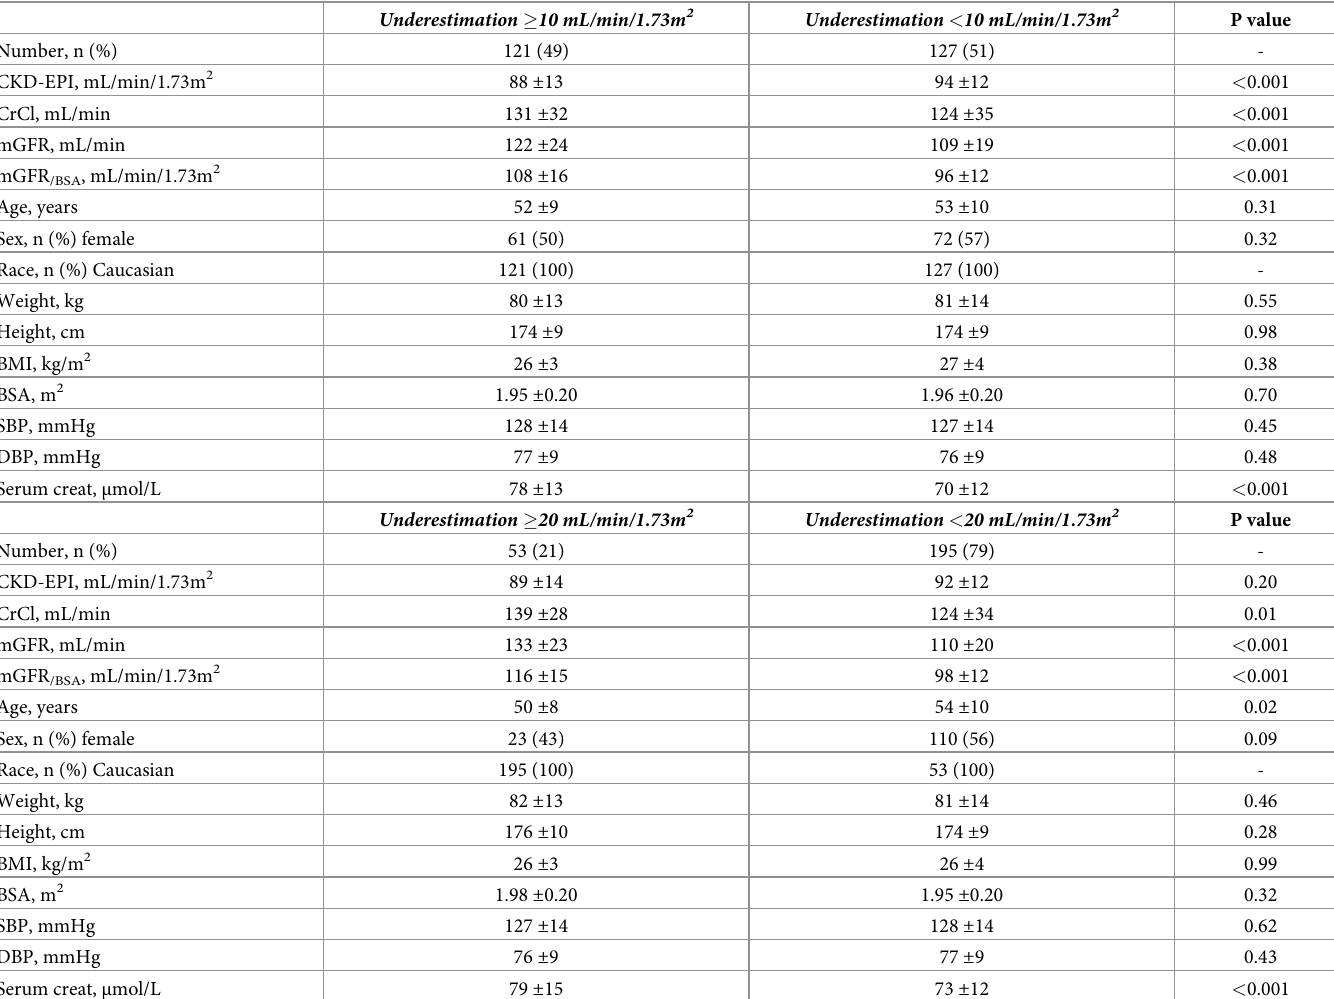
Table 1. Pre-donation characteristics of donors from the mGFR-cohort with an underestimation of mGFR BSA by eGFR � 10 mL/min/1.73m 2